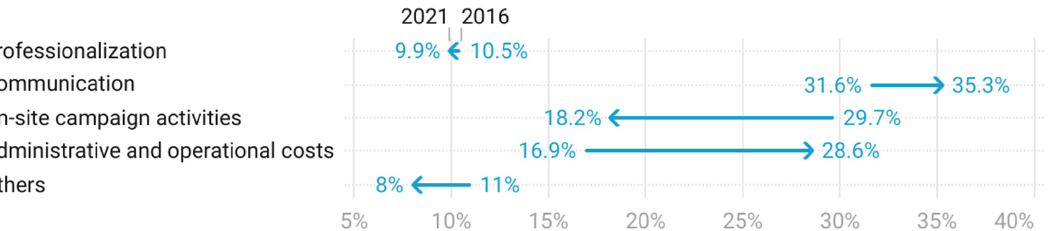
Figure 7. Investment in professionalization (actual expenses). Comparison between the 2016 and 2021 presidential election campaigns. Source: Own coding of data collected from ECFP (https://www.tribunalconstitucional.pt/tc/contas_eleicoes-pr.html, accessed on 11 September 2022). Note: Absolute values are displayed in the Appendix A (Table